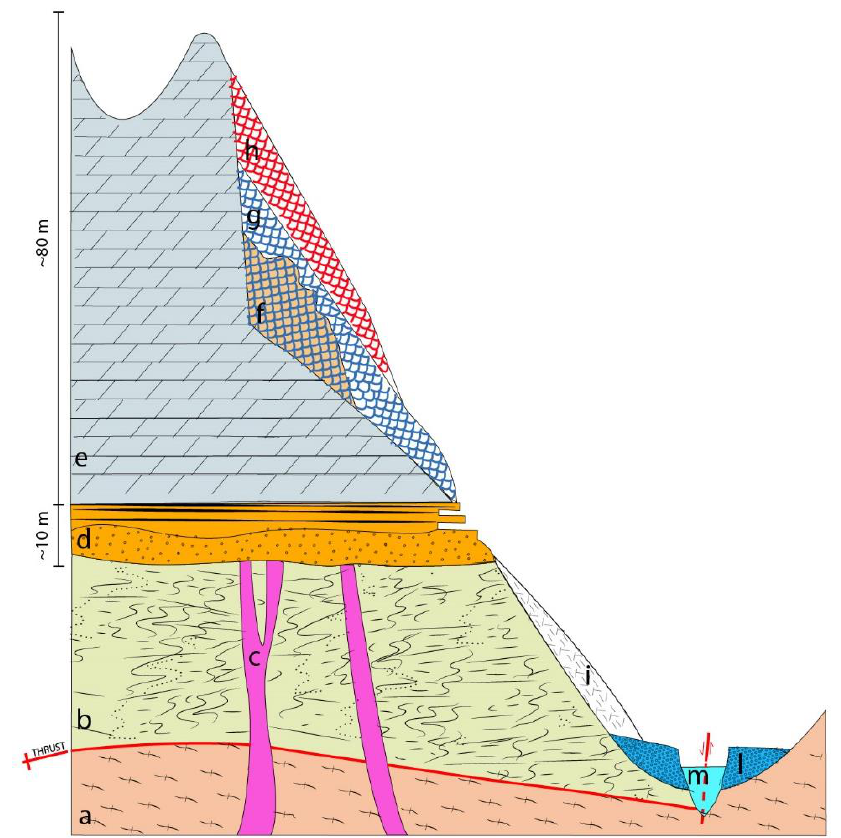
Figure 3. Lithostratigraphic sketch of lithological units: Low-grade metamorphic rocks: (a) Monte Santa Vittoria Fm; (b) Filladi del Gennargentu Formation; (c) granitic plutonic complex and dikes; marine and transitional Mesozoic sedimentary succession; (d) gluvial and deltaic conglomerates, sandstones, and mudstones (Genna SeloleFormation); (e) dolostone (Dorgali Formation); (f) cemented paleo-rockfall deposits; (g) paleo-rockfall deposits; (h) active rockfall; (i) slope deposits; (l) terraced alluvial deposits; (m) alluvial deposits (modified after Demurtas et al. [6]).